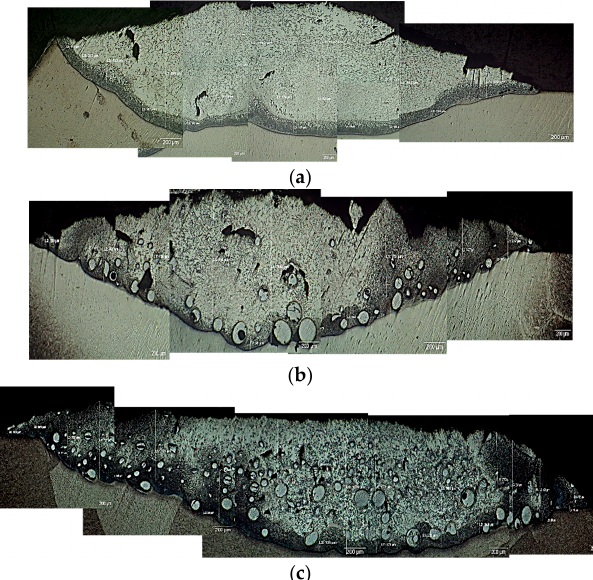
Figure 3. Light micrographs of cross-sections of the deposited layers of ( a ) sample 1, ( b ) sample 2, and ( c ) sample 3.